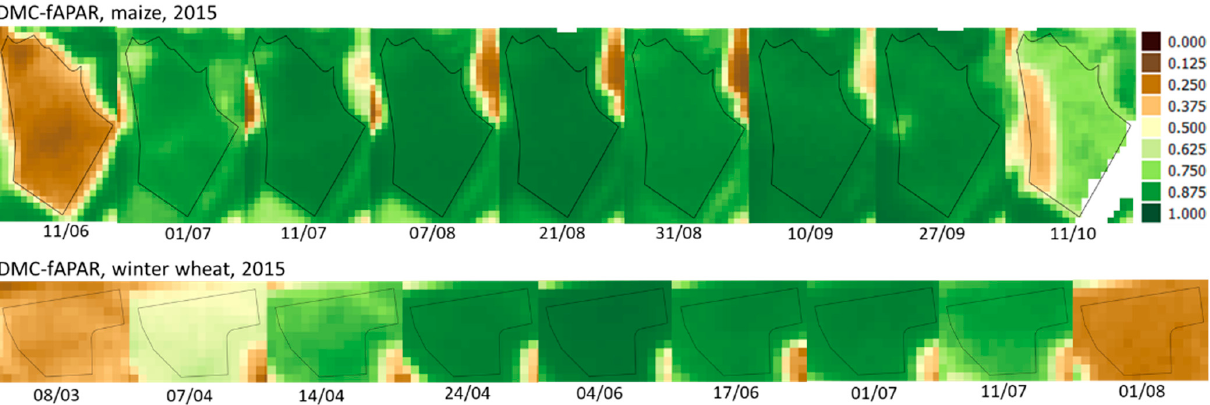
Figure 9. DMC-derived fCover and fAPAR versus days after planting/sowing (DAP) for maize fields in 2015 and related BBCH codes versus DAP. The comparatively higher revisit frequency and higher spatial resolution increase the probability and number of pure and cloud-free pixels per field for Sentinel-2 as compared to DMC (Figure 10). Models that suited all fields per crop were difficult to develop since the probability of cloud- or shadow-contaminated values also increased with higher re- visit frequencies, adding to the variability between fields and years.